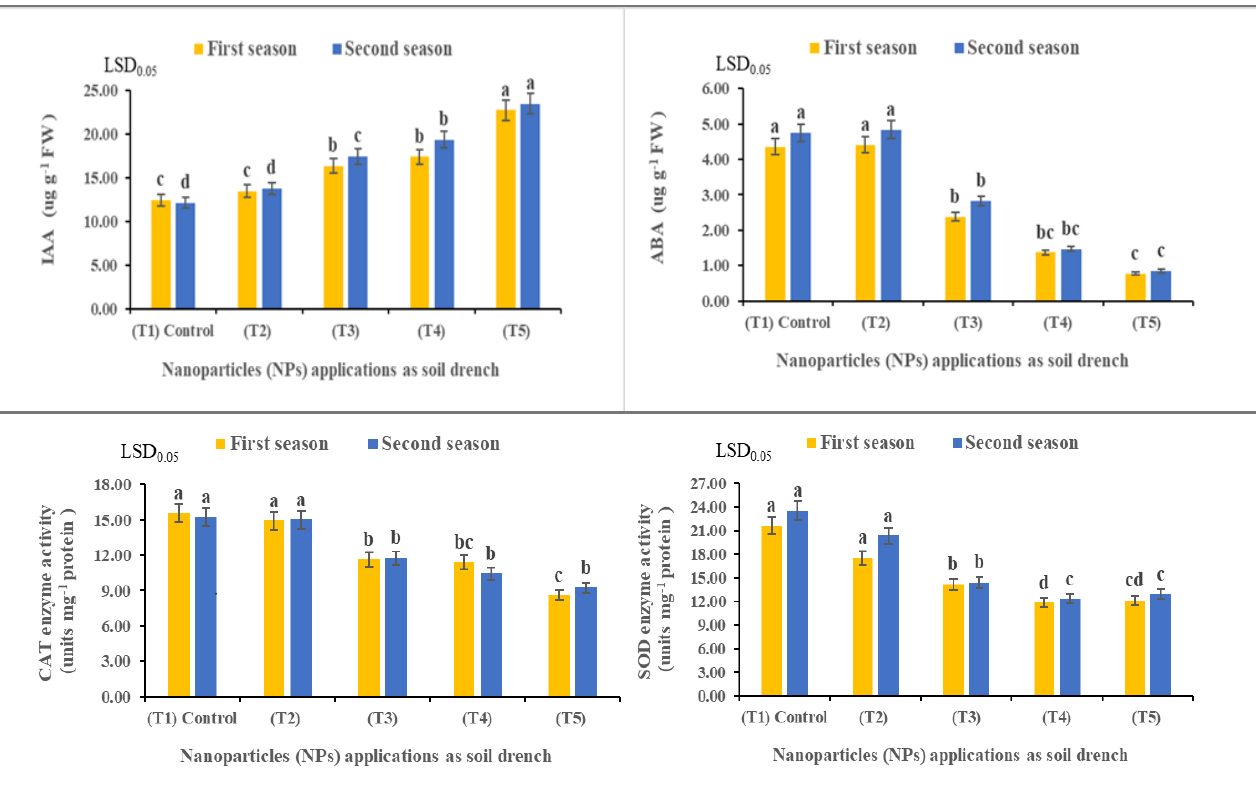
Figure 7. Leaf phytohormones and enzyme activities under drought conditions and different nanoparticle applications on Solidago canadensis plants during the 2020 and 2021 growing seasons. Different letters show statistically significant differences declared by Duncan’s Multiple Range Test LSD at p ≤ 0.05. (T1) NPK = chemical fertilizer, (T2) n-Si = silicon nanoparticles, (T3) n-NPK = NPK nanoparticles, (T4) n-ZE-loaded N = nano-zeolite-loaded nitrogen, (T5) n-Si+ n-ZE-loaded N = silicon nanoparticles + nano-zeolite-loaded nitrogen, IAA = indole-3-acetic acid, ABA = abscisic acid, CAT = catalase enzyme, SOD =superoxide dismutase